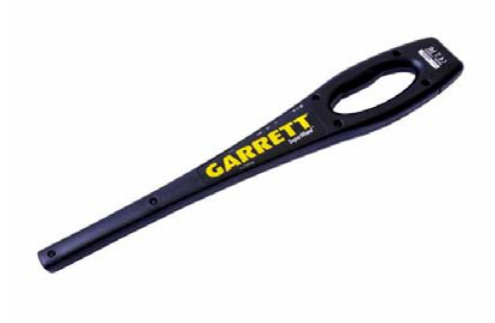
Figure 6 – Handheld metal detector Garrett SuperWand Рис . 6 – Ручной металлодетектор Garrett SuperWand Слика 6 – Ручни метал - детектор Garrett SuperWand